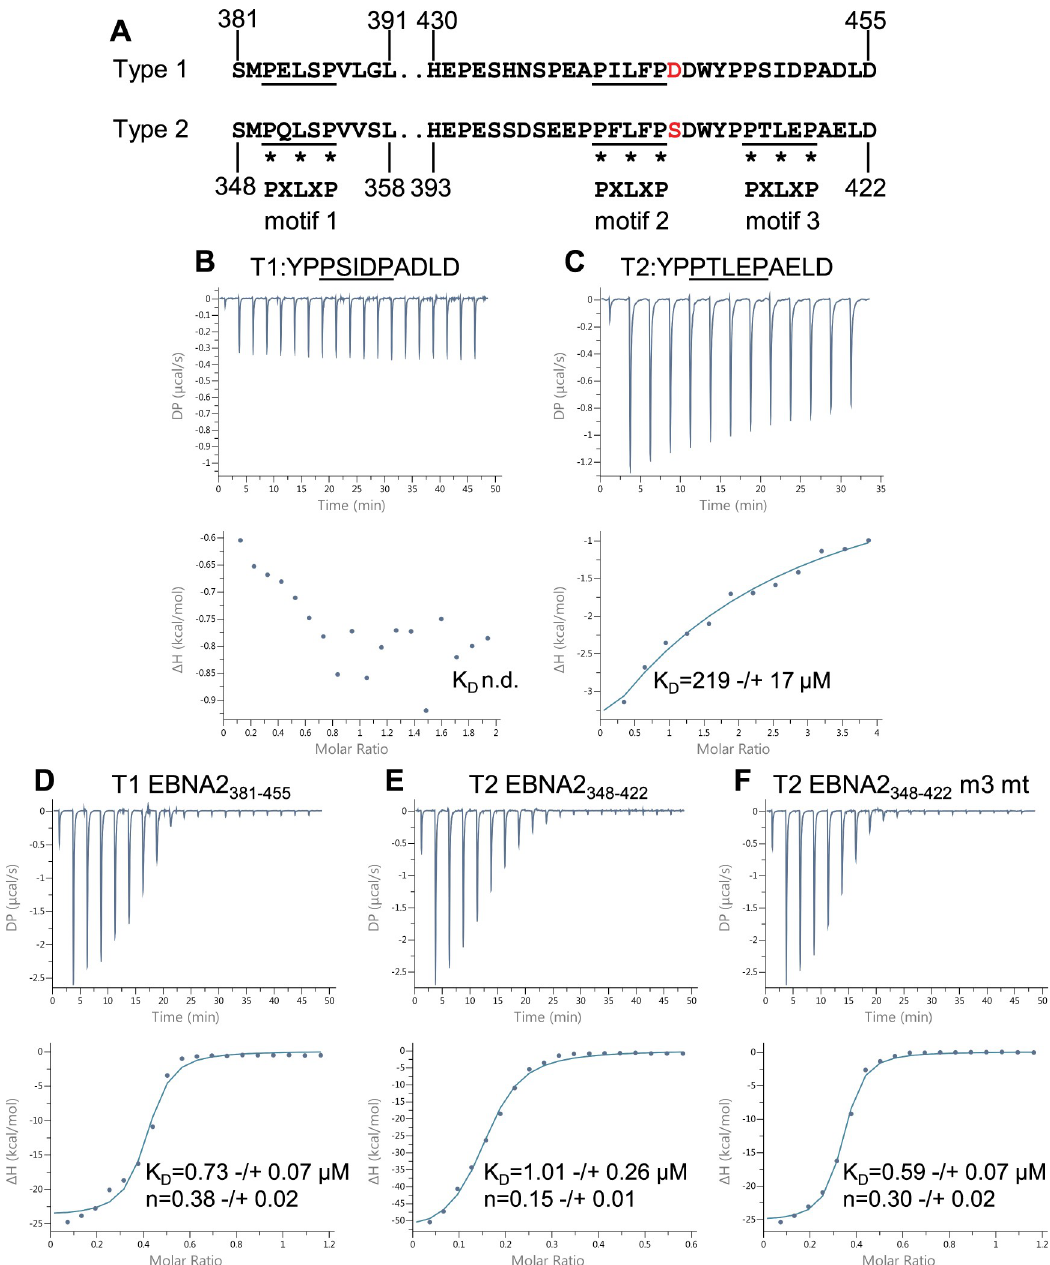
Fig 2. Isothermal titration calorimetry analysis of the interaction of type 1 and type 2 EBNA2 peptides and polypeptides containing BS69 binding motif 3 with BS69 CC-MYND . (A) Amino acid sequence of the regions of type 1 (B95-8) and type 2 (AG876) EBNA2 containing BS69 binding motifs 1, 2 and 3 (underlined). Asterisks show the positions of the P, L and P amino acids in the PXLXP binding motif. (B) Isothermal titration calorimetry (ITC) analysis of type 1 EBNA2 motif 3 peptide binding to BS69 CC-MYND (no binding was detected so the K D could not be determined (n.d.). (C) Isothermal titration calorimetry (ITC) analysis of type 2 EBNA2 motif 3 peptide binding to BS69 CC-MYND using 19 injections of 2.0 μ l EBNA2 peptide. Data are displayed and analysed as in Fig 1. (C) ITC analysis of the binding of type 2 EBNA2 motif 3 peptide binding to BS69 CC-MYND as in B. (D) ITC analysis of the binding of the type 1 EBNA2 polypeptide EBNA2 381-455 to BS69 CC-MYND. (E) ITC analysis of the binding of the type 2 EBNA2 polypeptide T2 EBNA2 348-422 to BS69 CC-MYND . (F) ITC analysis of the binding of the type 2 EBNA2 polypeptide T2 EBNA2 348-422 with BS69 binding motif 3 mutated from PTLEP to ATAEA.